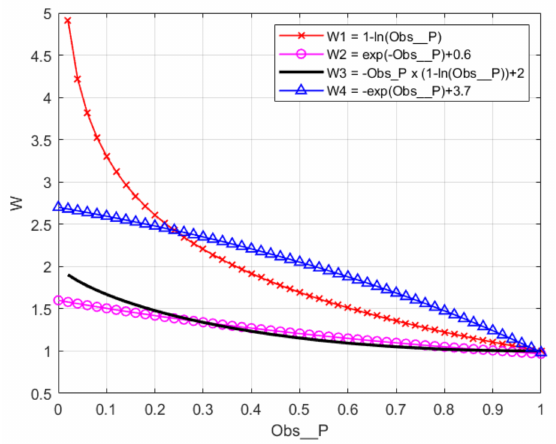
Figure 4. Four adaptive weight function curves based on barrier distribution rate.